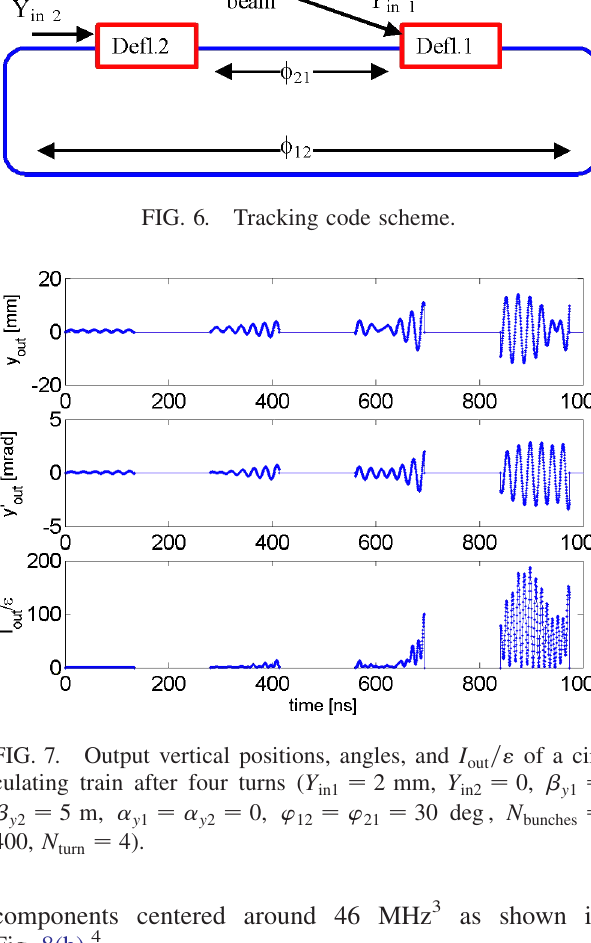
FIG. 7. Output vertical positions, angles, and I culating train after four turns ( Y ¼ 5 m , (cid:6) ¼ (cid:6) ¼ 0 , ’ (cid:5) y 2 y 1 y 2 ¼ 400 , N turn